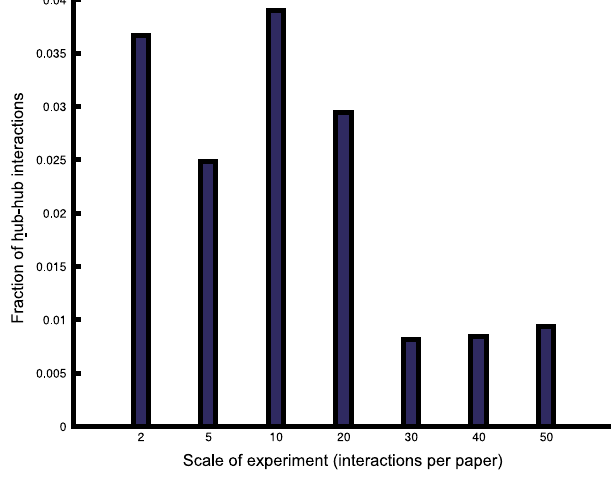
Figure 3. Fraction of Hub–Hub Interactions Reduce with Scale of Experiments Protein interactions from the LC dataset were separated into subgroups based on the number of interactions reported in the same publication, which was taken as a proxy for experimental scale. For each sub-network, hubs were defined as protein with connectivity exceeding the 90th percentile. The strong negative correlation ( r ¼ (cid:1) 0.85, p , 0.01, Spearman) indicates that as the size of the screen increases, bias against hub–hub interactions begins to appear. DOI: 10.1371/journal.pbio.0040317.g003